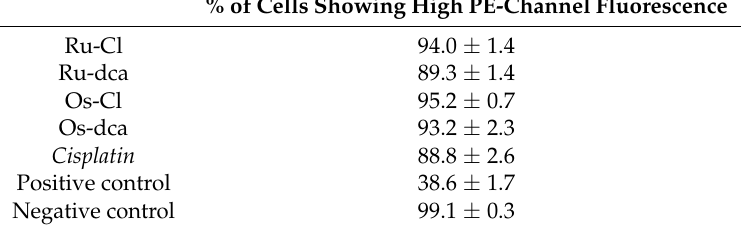
Table 3. The results (given as % cell populations) of flow cytometry studies of the mitochondrial membrane potential changes, studied at the A2780 cells using the 24 h treatment by the IC 50 concentrations of complexes Ru-Cl , Ru-dca , Os-Cl and Os-dca (and cisplatin for comparative purposes). The untreated A2780 cells were employed as the negative control, while the CCCP-treated cells represent the positive control. The data are given as arithmetic means ± SD from three independent experiments.